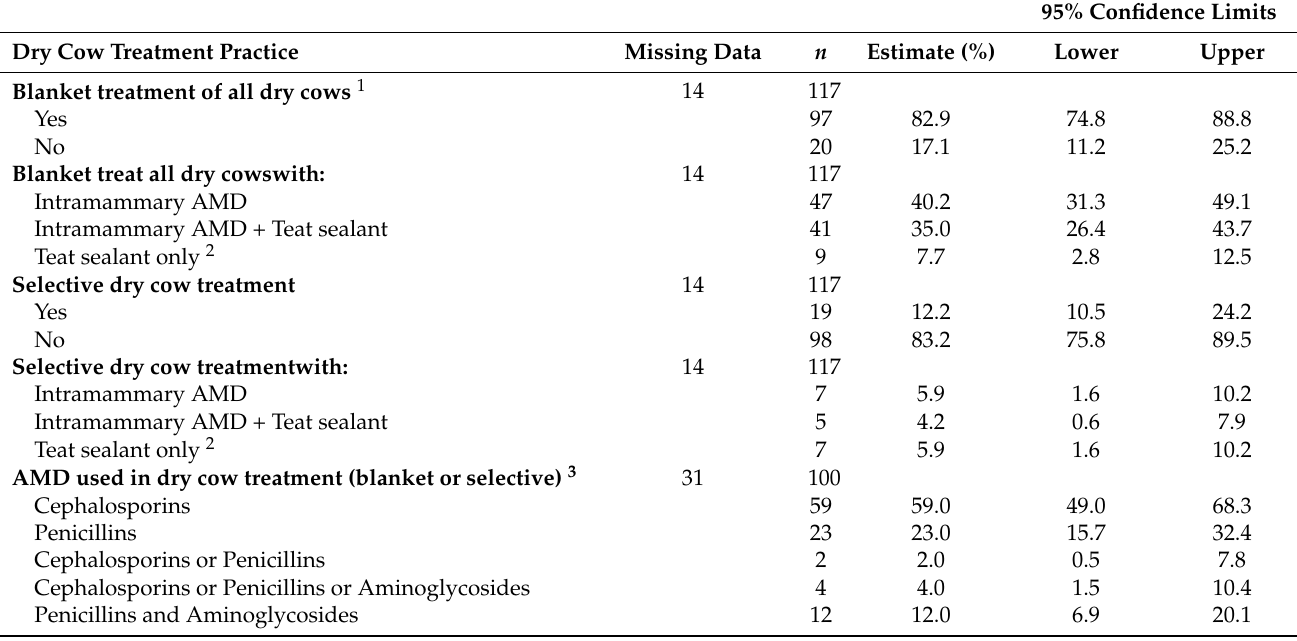
Table 2. Summary of dry cow treatment practices from responses to a questionnaire on antimicrobial drug (AMD) use in adult cows on California dairies during